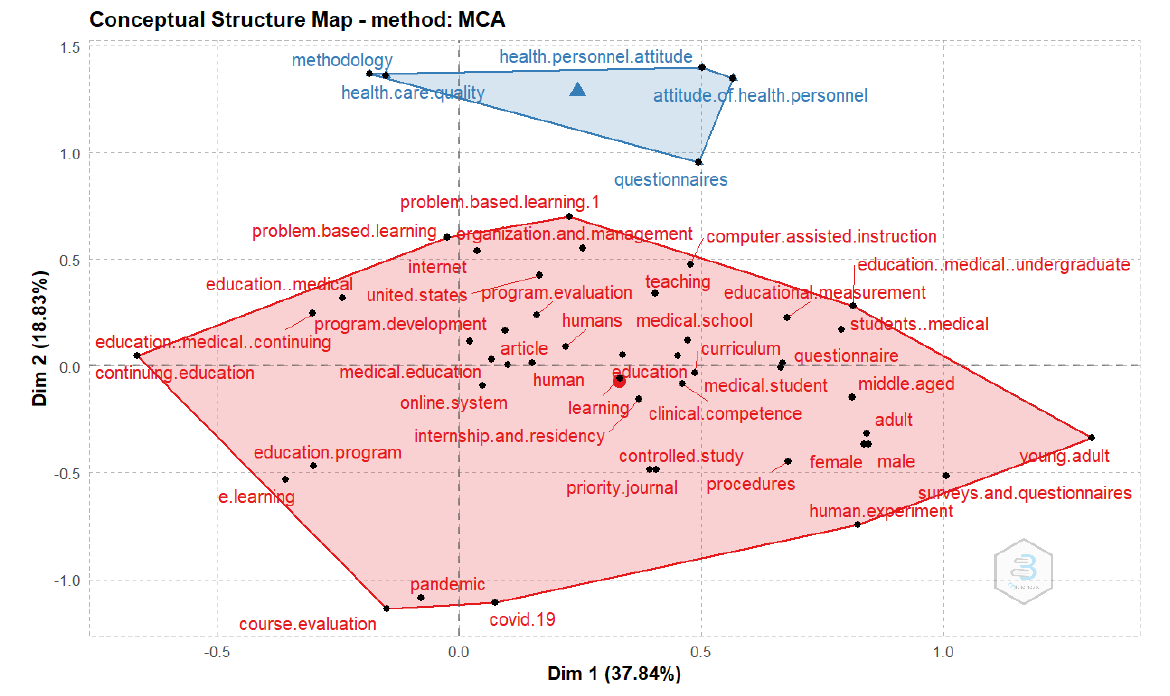
Figure 12. Factorial analysis using the Multiple Correspondence Analysis (MCA) method.